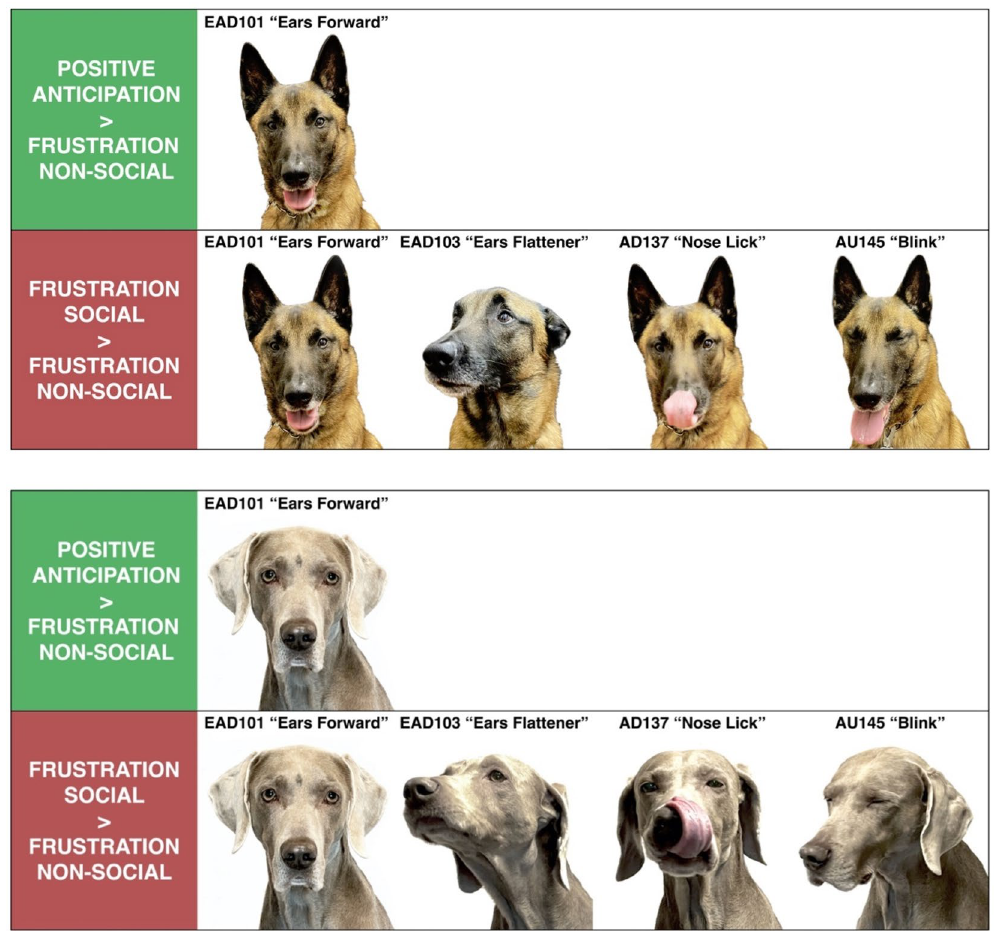
Figure 1. Facial expressions that occurred significantly more in the positive anticipation compared to the frustration non-social (in green) and facial expressions that occurred significantly more in the frustration social compared to the frustration non-social condition (in red). An example of a shepherd type and hunting type dog are